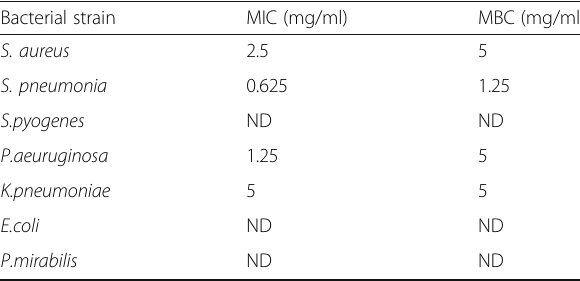
pounds of modern prescription drugs as we know today [6]. Antibiotic resistance is a major concern and develop- ment of new agents from plants could be useful in meet- ing the demand for new antimicrobial agents with improved safety and efficacy. Table 3 MIC and MBC of H.micranthus leaves extract against test organisms Bacterial